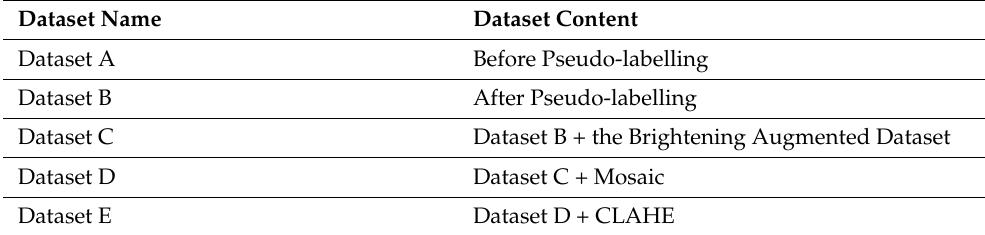
Table 5. Dataset Naming